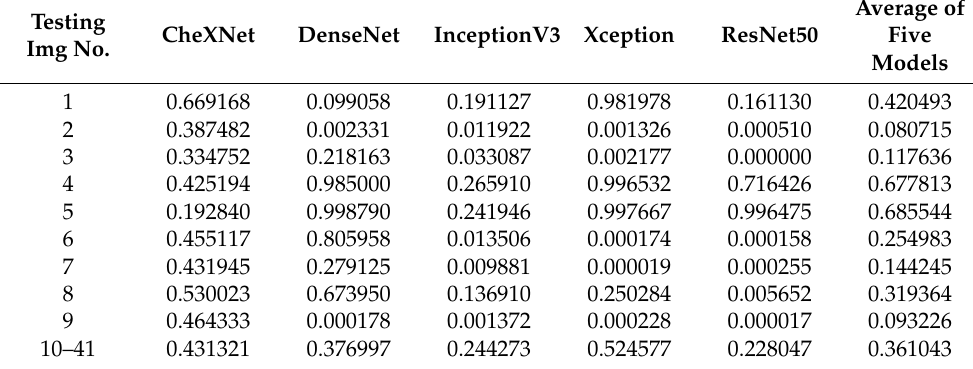
Table 5. Average testing probabilities of five models on RCFV dataset 3.